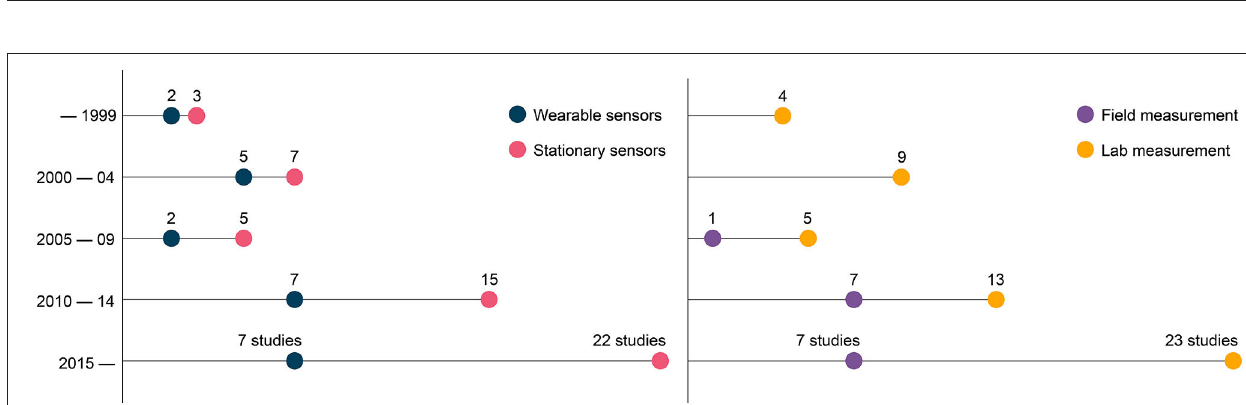
Frontiers in Physiology |